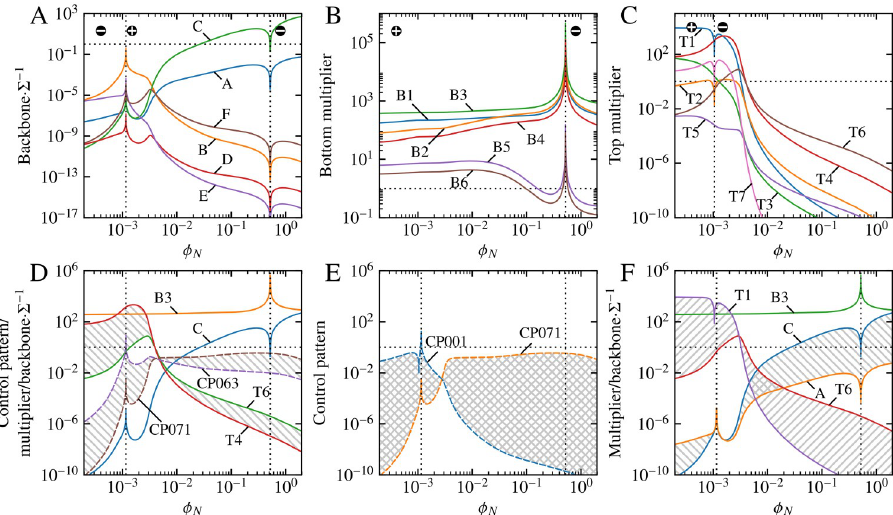
Fig 4. Backbone and multiplier patterns of the C J 6 control patterns as functions of ϕ N . (A) Values of the backbone v 3 patterns (A–F) scaled by the control coefficient common denominator ( S ) of this pathway. (B) Values of the multiplier patterns consisting of components from the bottom half of the reaction scheme in Fig 2 (B1–B6). (C) Values of the multiplier patterns consisting of components from the top half of the reaction scheme (T1–T7). (D) CP063 and CP071 together with their constituent scaled backbone and multiplier patterns. CP063 and CP071 differ only in their top multipliers (T4 and T6), as is reflected by the corresponding hatched areas between the pairs CP063/CP071 and T4/T6. (E) CP001 and CP071. (F) The constituent scaled backbone and multiplier components of CP001 and CP071. CP001 and CP071 differ both in terms of their backbones (A and C) and their top multipliers (T1 and T6); these differences are indicated with hatching between T1/T6 and A/C, and their cumulative effect is indicated with hatching between CP001/CP071 in (E). The horizontal black dotted line at y = 1 differentiates between patterns that have an increasing ( y > 1) or diminishing ( y < 1) effect on their control pattern products. Absolute values of pattens are taken to allow for plotting logarithmic coordinates; the crossover from positive to negative values with increasing ϕ is indicated by N vertical dotted lines. Backbone patterns each switch sign twice from a negative starting point on the left-hand side of (A). The multiplier patterns T3, T4, T5, and T6 are positive throughout the ϕ N range, whereas the remaining T multipliers switch from positive to